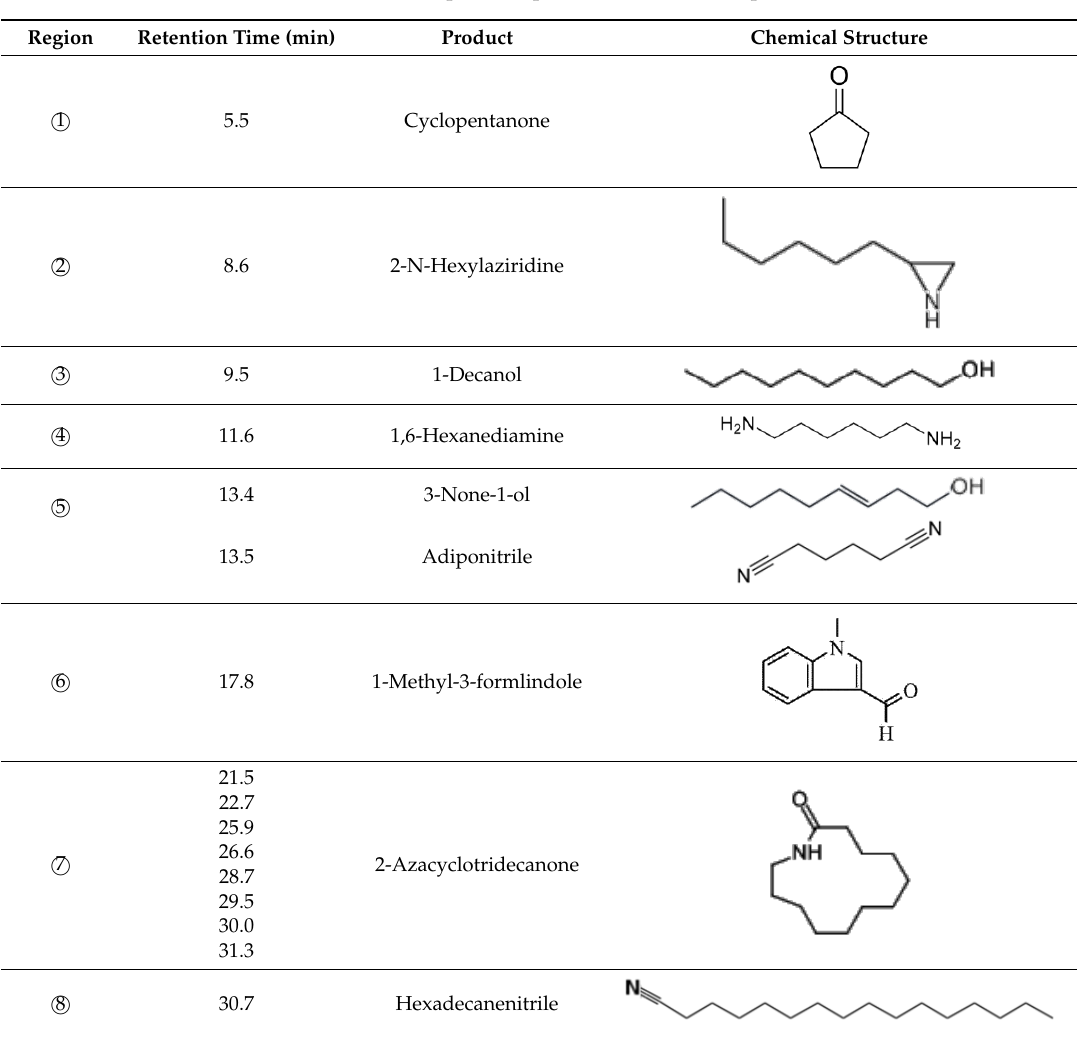
Table 3. The decomposition products of PA66 composites.